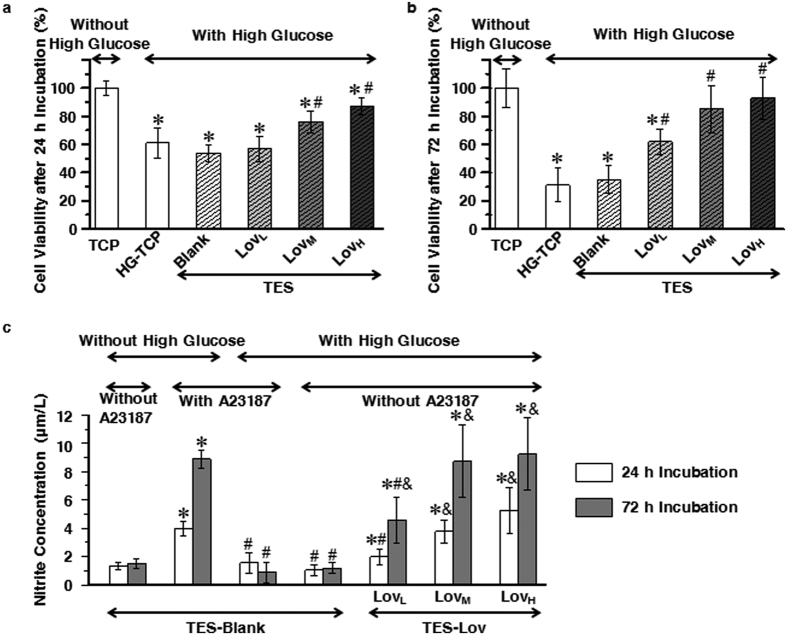
Effects of Lov-loaded TES on high-glucose induced cell damage in HUVECs.(a,b) Cell viability of HUVECs seeded on TCP, TES-Blank, TES-LovL, TES-LovM, and TES-LovH in high-glucose conditions, after 24 h (a) and 72 h (b) of incubation, with the cells on TCP in normal medium serving as controls. All values represent the means and SD; n = 6; *p < 0.05, vs TCP without high glucose; #p < 0.05, vs TES-Blank with high glucose. (c) NO synthesis of HUVECs seeded on TES-Blank, TES-LovL, TES-LovM, and TES-LovH in medium with or without high glucose and A23187 after 24 and 72 h of incubation. All values represent the means and SD; n = 6; *p < 0.05, vs TES-Blank without high glucose or A23187; #p < 0.05, vs TES-Blank with A23187 but without high glucose; &p < 0.05, vs TES-Blank with high glucose but without A23187.